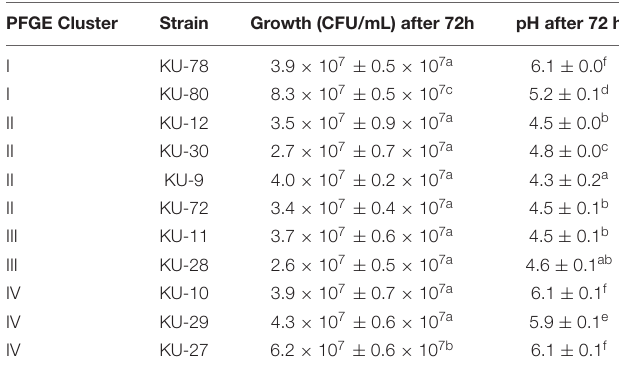
TABLE 1 | Growth of D. hansenii strains and change in pH of MYGP broth added 4% (w/v) NaCl after 72h inoculation at 25 ◦ C. PFGE